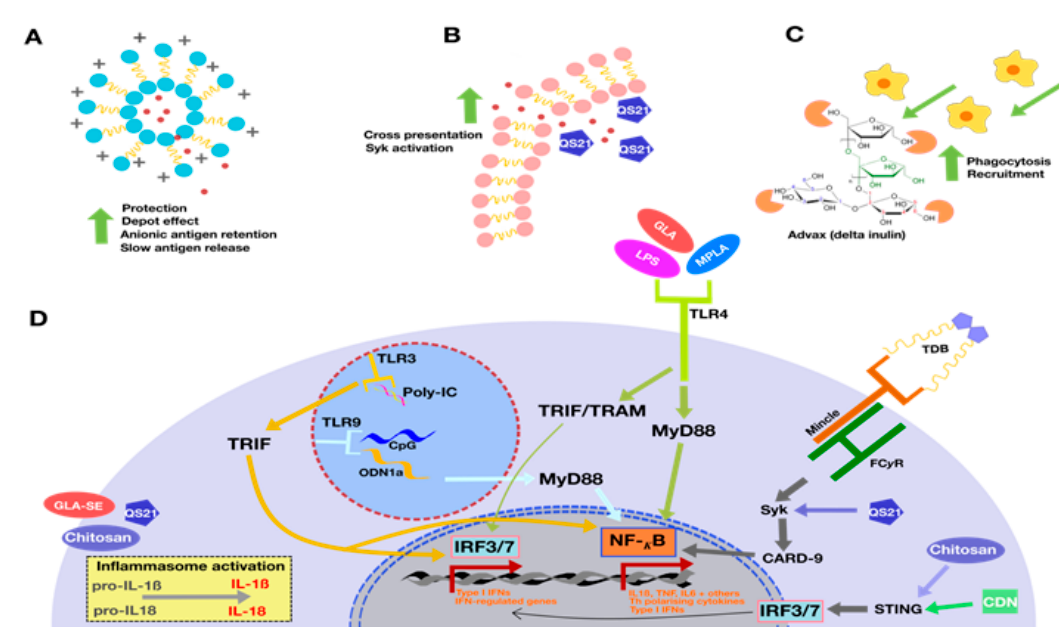
Figure 1. Proposed mechanism of action of adjuvants used in subunit tuberculosis vaccine candidate formulations. Many compounds exploit structural features to achieve adjuvanticity ( A – C ). Liposomal formulations, particularly cationic liposomes ( A ), protect and retain anionic vaccine antigens whilst creating a depot effect that potentiates slow antigen release. Adjuvant components such as QS21, found in AS01, interact with and disrupt the liposomal membranes ( B ), enhancing cross presentation to CD8 + T cells and inflammatory cytokine production via the Syk tyrosine kinase pathway. The novel polysaccharide adjuvant, Advax™, ( C ) potentiates phagocytosis and recruits immune cells to the site of vaccination, despite minimal inflammatory effects. Other adjuvants rely on distinct molecular pathways known to induce inflammation, such as the activation of pattern recognition receptors, both intracellular (Poly:IC (toll-like receptor (TLR)3, TLR7 /8 , or CpG oligonucleotides (TLR9)) or extracellular (TLR2, 3-O-desacyl-4 ′ -monophosphoryl lipid A (MPLA; TLR4), and Mincle). Chitosan and cyclic dinucleotides (CDNs) activate the cytoplasmic DNA sensor STING.